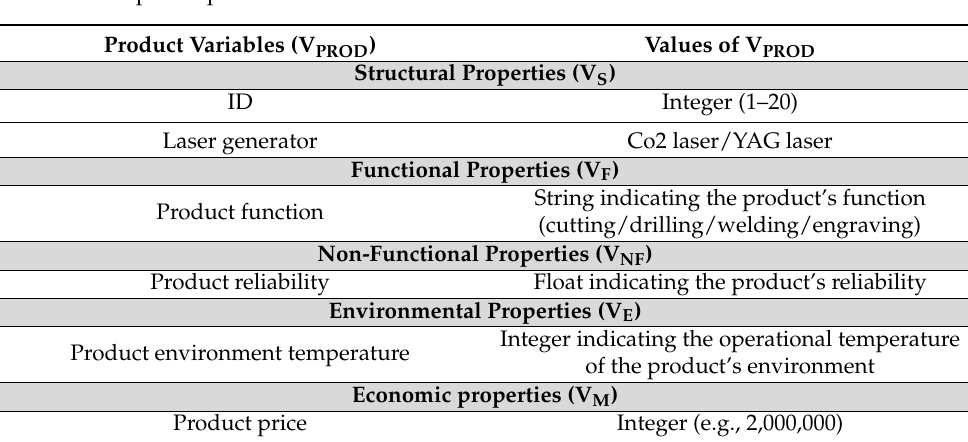
Table 5. Examples of product